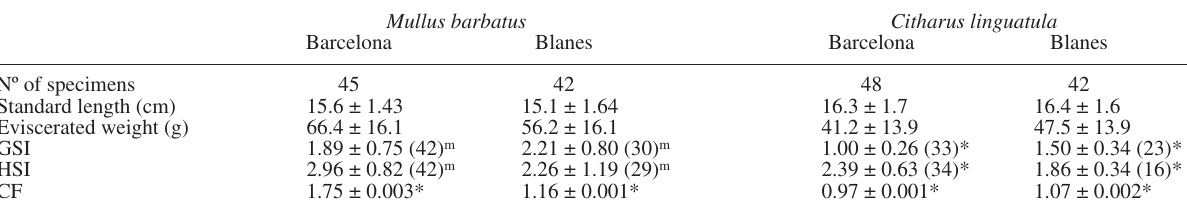
Table 1. – Means and standard deviations of standard length (cm), eviscerated weight (g), gonadosomatic index (GSI), hepatosomatic index (HSI) and condition factor (CF) in Mullus barbatus and Citharus linguatula from both locations. Parenthesis values: number of specimens analysed; * significant difference between locations, m marginally significant values ( P